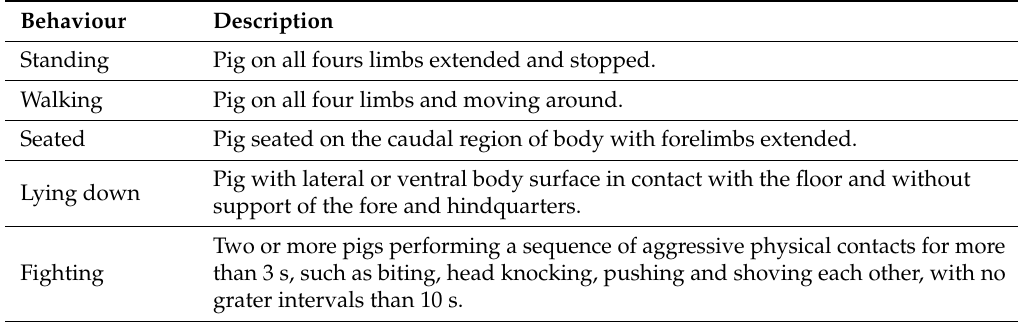
Table 1. Ethogram of pigs’ behavior during